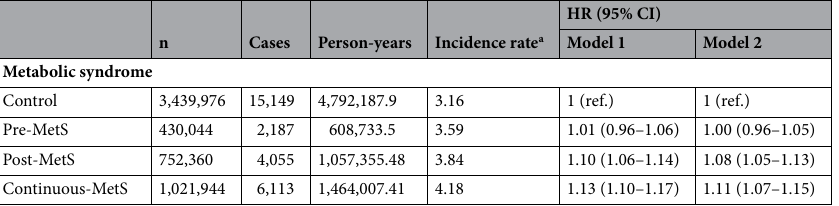
Table 3 shows differences in risk of psoriasis based on changes in MetS components criteria from 2009 to 2012. For the waist circumference criterion, after adjusting for age, sex, smoking, alcohol consumption, exercise, and BMI, we found significant increases in risk of psoriasis in the pre-MetS (HR, 1.05; 95% CI, 1.00–1.11), post- MetS (HR, 1.09; 95% CI, 1.04–1.14), and continuous-MetS (HR, 1.15; 95% CI, 1.10–1.20) groups compared with the control group. For the TG criterion, the pre-MetS (HR, 0.99; 95% CI, 0.95–1.03) group had a risk similar to that of the control group, but both the post-MetS (HR,1.09; 95% CI, 1.05–1.13) and continuous-MetS (HR,